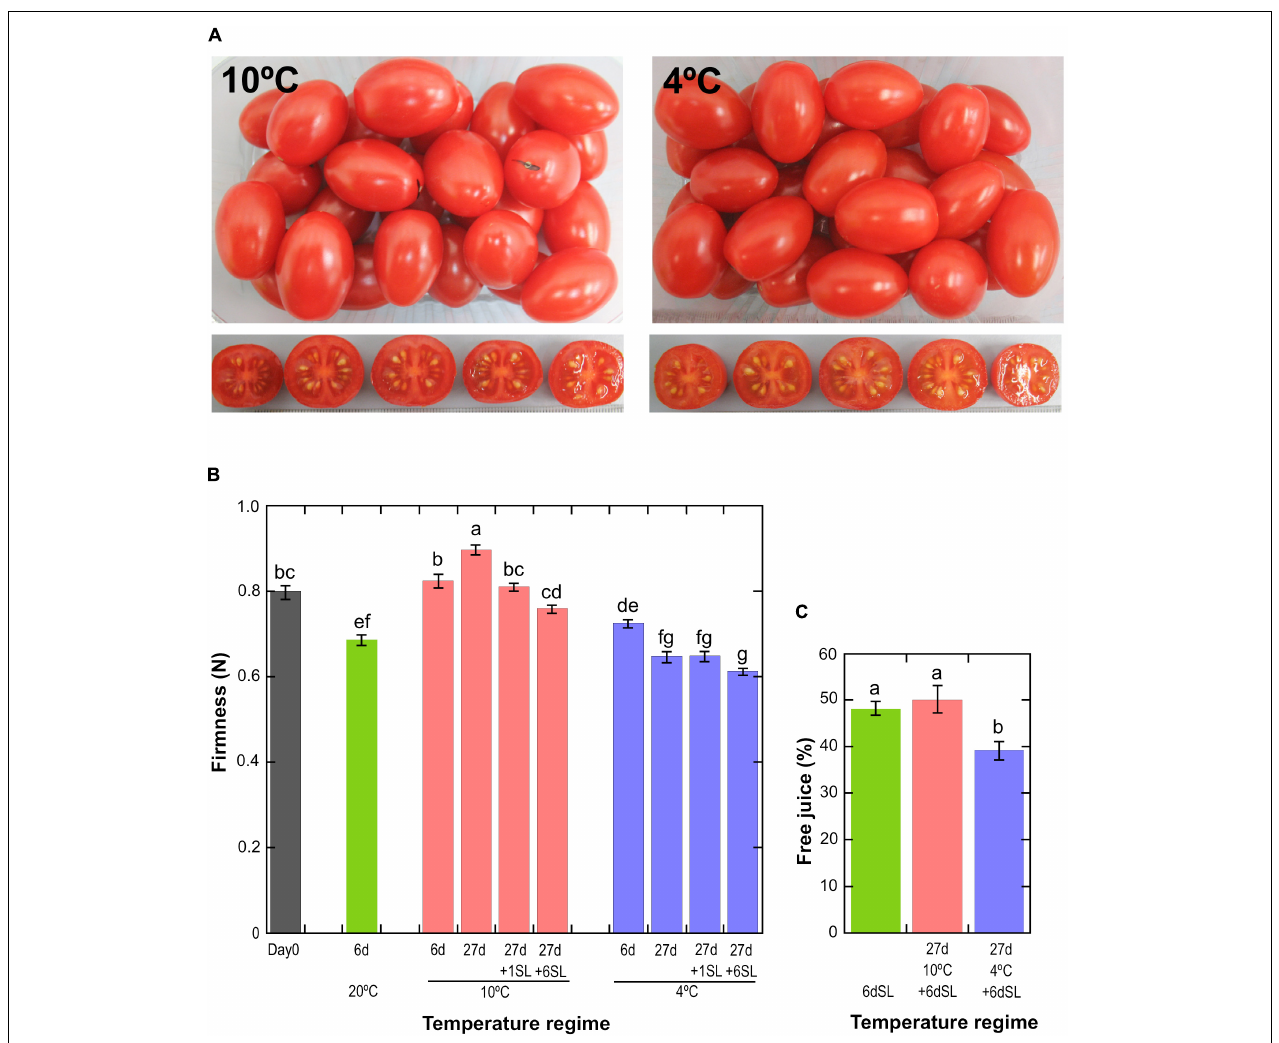
FIGURE 1 | Physiological effects of storage at different temperatures. (A) Fruit appearance after storage at 10 or 4 ◦ C for 27 days, followed by an additional 6 days at a shelf temperature of 20 ◦ C. (B) Mean fruit firmness ± SE ( n = 72) measured by compression. Storage at 20 ◦ C for 6 days, or 10 or 4 ◦ C for up to 27 days with or without an additional shelf-life (SL) period of 1 or 6 days. Means not sharing a common letter are significantly different between groups at P = 0.05 as determined by LSD after a one-way ANOVA. (C) Mean pericarp free juice ± SD ( n = 6) as determined using a homogenate and centrifugation method. Fruit were stored for 6 days at 20 ◦ C, without or with prior storage for 27 days at 10 or 4 ◦ C. Means not sharing a common letter are significantly different between groups at P = 0.001 as determined by LSD after a one-way